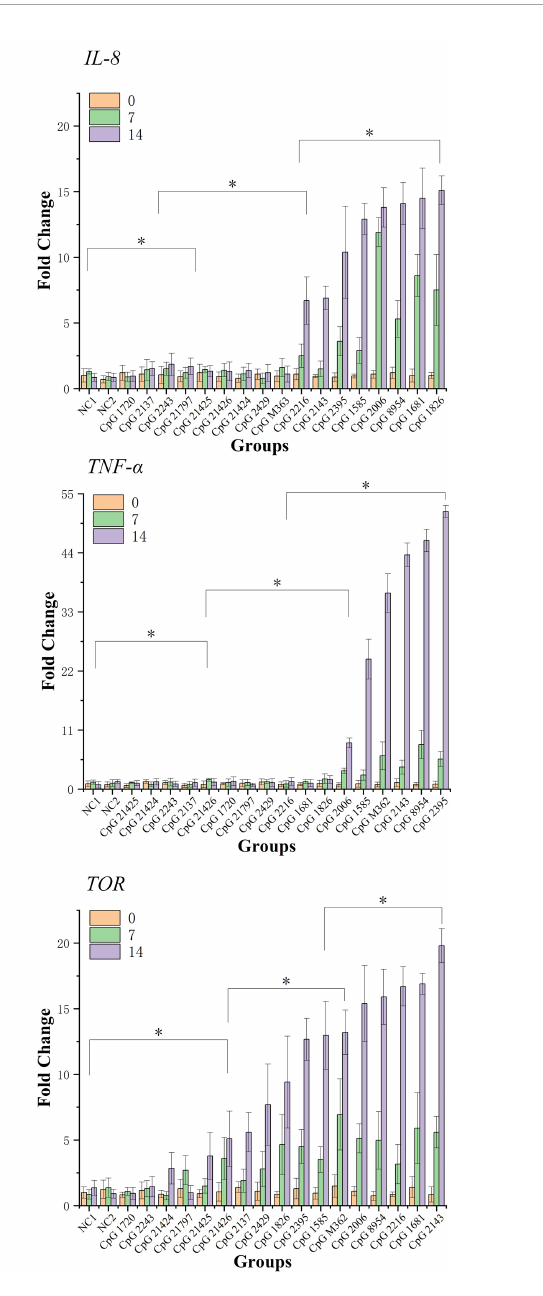
FIGURE 1 qPCR analysis of the expression of six immune-related genes detected in hepatopancreas of shrimps at 0-, 7- and 14-days. Data are means for three assays and presented as the means ± SD ( p < 0.05). The symbol * indicates signi fi cant differences (p <